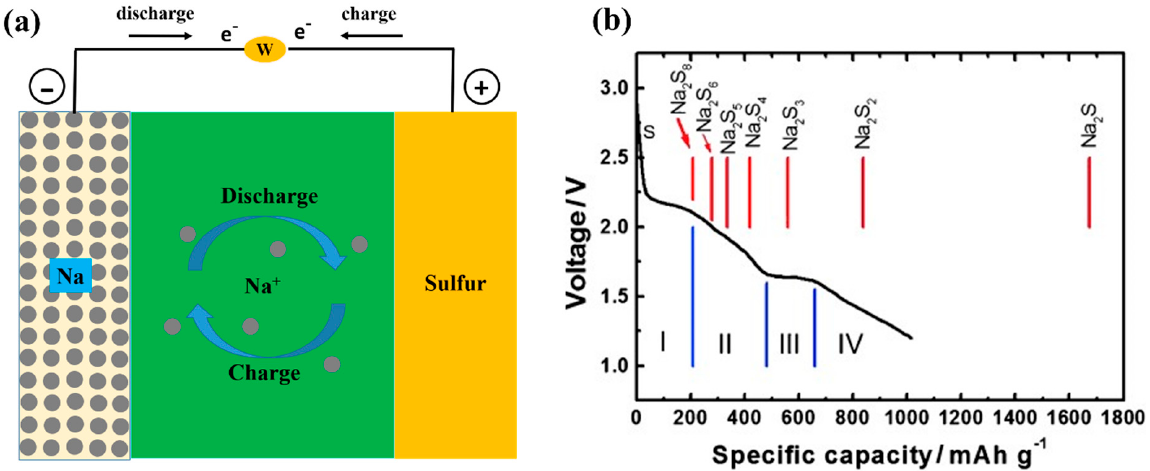
Figure 3. ( a ) Schematic representation of the room-temperature sodium–sulfur (RT Na-S battery);